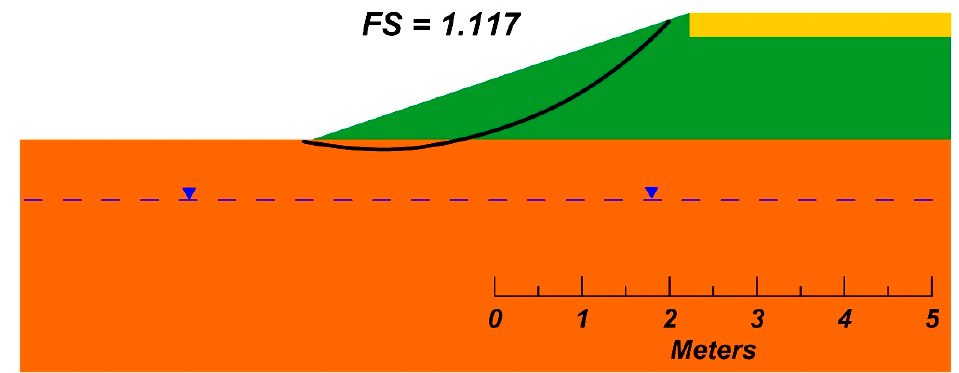
Figure 11. Slip surface for the residual shear strength estimated by the power envelope without suction.